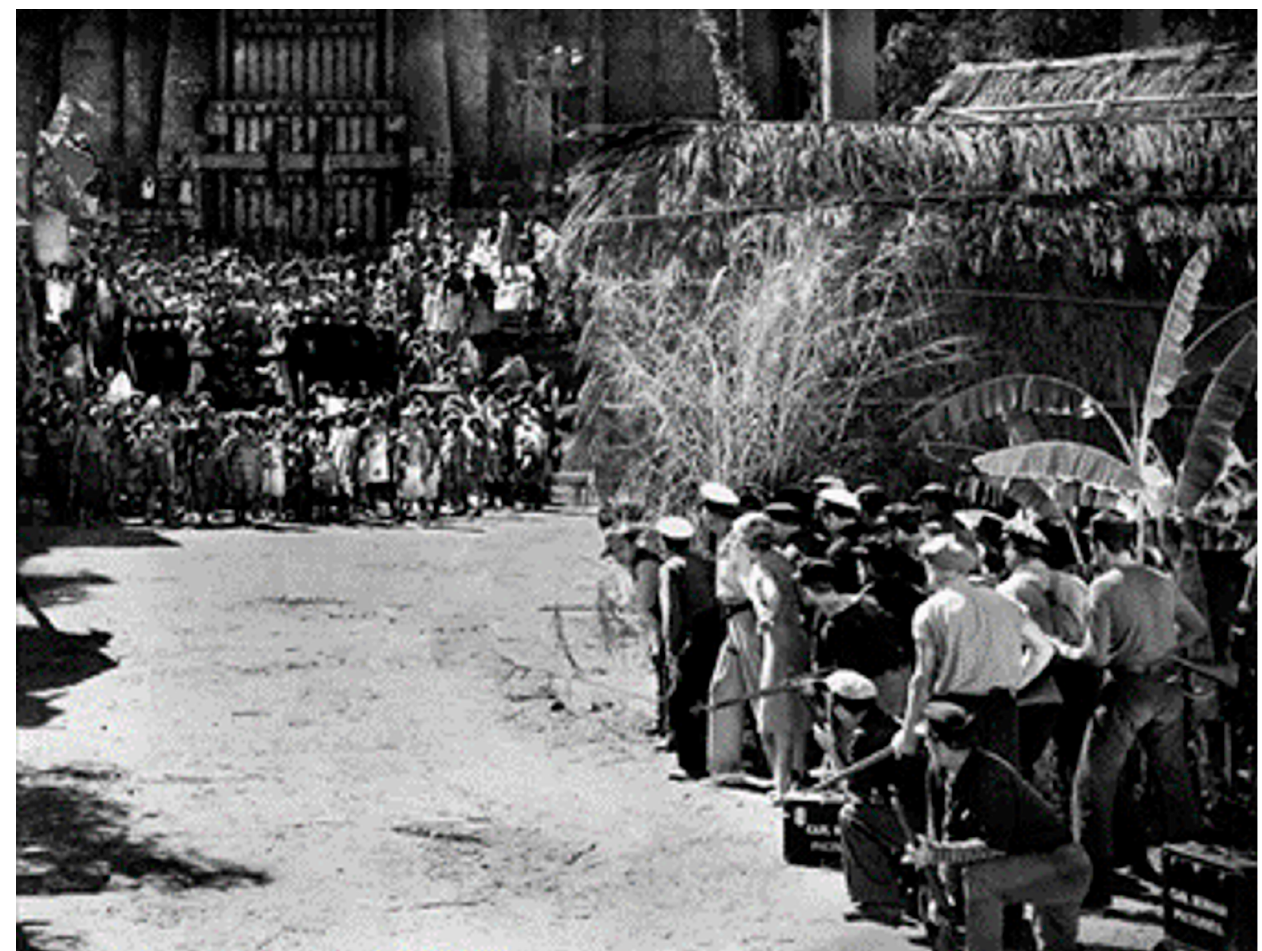
Figure 25. The outsiders contemplate, “hunt”, the rites of the natives. https://c4.wallpaperflare.com/wallpaper/96/407/736/movie-king-kong-1933-wallpaper-preview.jpg (accessed on 1 January 2021).